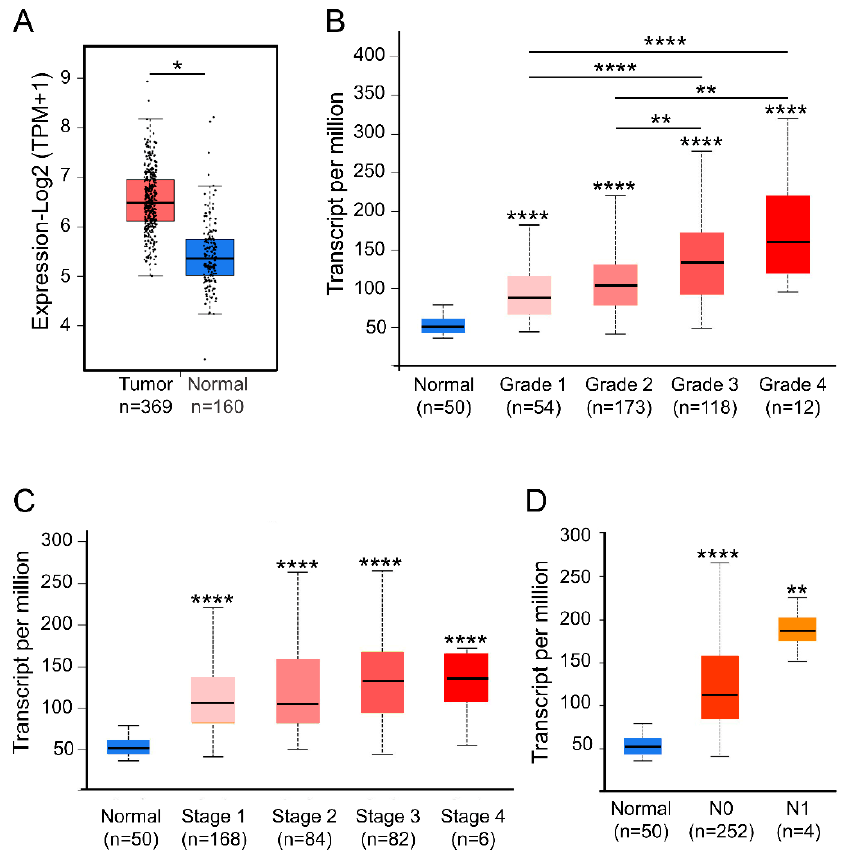
Figure 2. FKBP1A transcription level was significantly increased in LIHC patients. ( A ) Box plots of FKBP1A mRNA expression in normal liver and tumor samples based on GEPIA database. ( B – D ) FKBP1A mRNA level in LIHC patients based on different variables by using the UALCAN database. ( B ) Normal individuals or LIHC patients with grade 1, 2, 3, or 4 tumors. ( C ) Normal individuals or in LIHC patients in stage 1, 2, 3, or 4. ( D ) Normal individuals and LIHC patients with lymph node metastasis. The unpaired Student’s t test was used to estimate the significance of difference in gene expression levels between groups. * p < 0.05, ** p < 0.01, **** p < 0.0001 vs. normal.